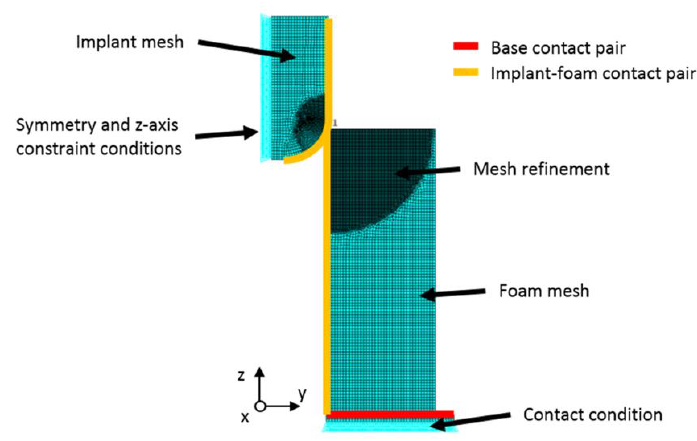
Figure 3. Axisymmetric Finite Element (FE) model of the experimental set-up to interpret results. Mesh refined close to the region of contact. Different boundary conditions used for the implant and analogue bone.